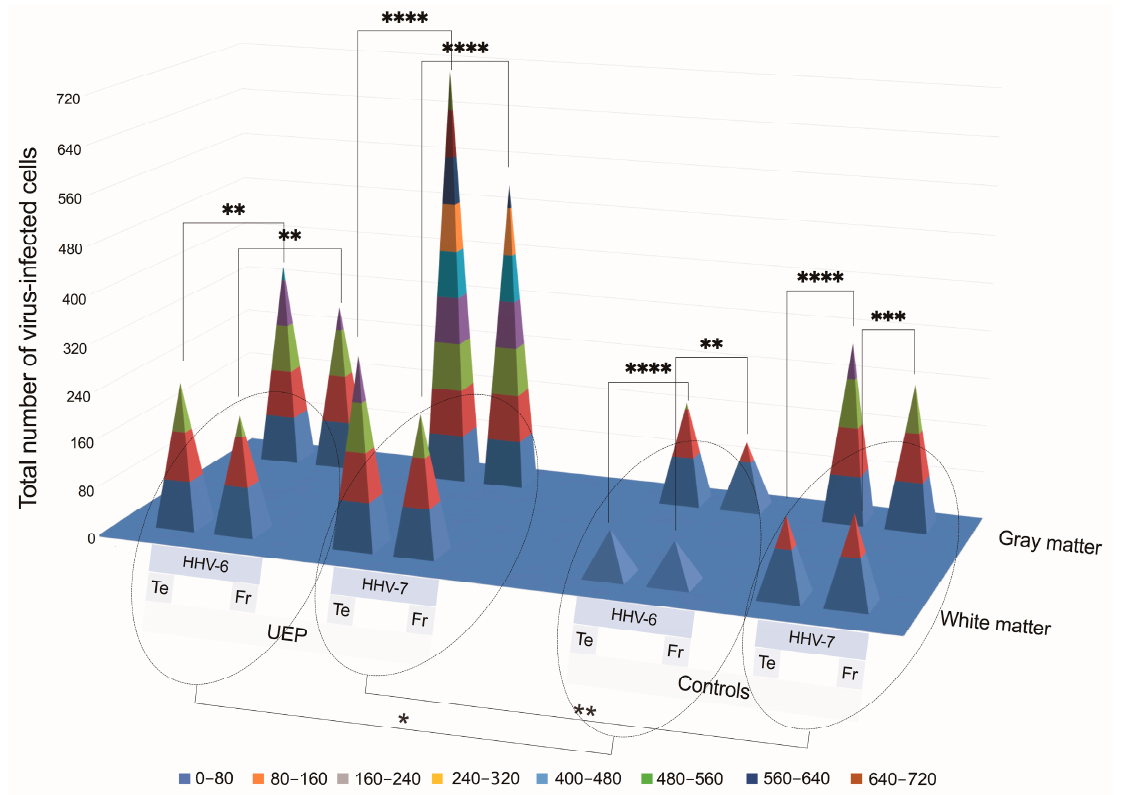
Figure 1. Pyramidal 3D surface plot represents the data of brain tissue immunohistochemical (IHC) analysis: total numbers of herpesvirus -6, -7 (HHV-6, -7) positive cells in the white and gray matter of the unspecified encephalopathy (UEP) group and controls. The blue plane represents a zero level (no virus-infected cells in the visual fields). Asterisks represent a significance level between different groups (* p < 0.05, ** p < 0.01, *** p < 0.001, **** p < 0.0001; chi-square test for